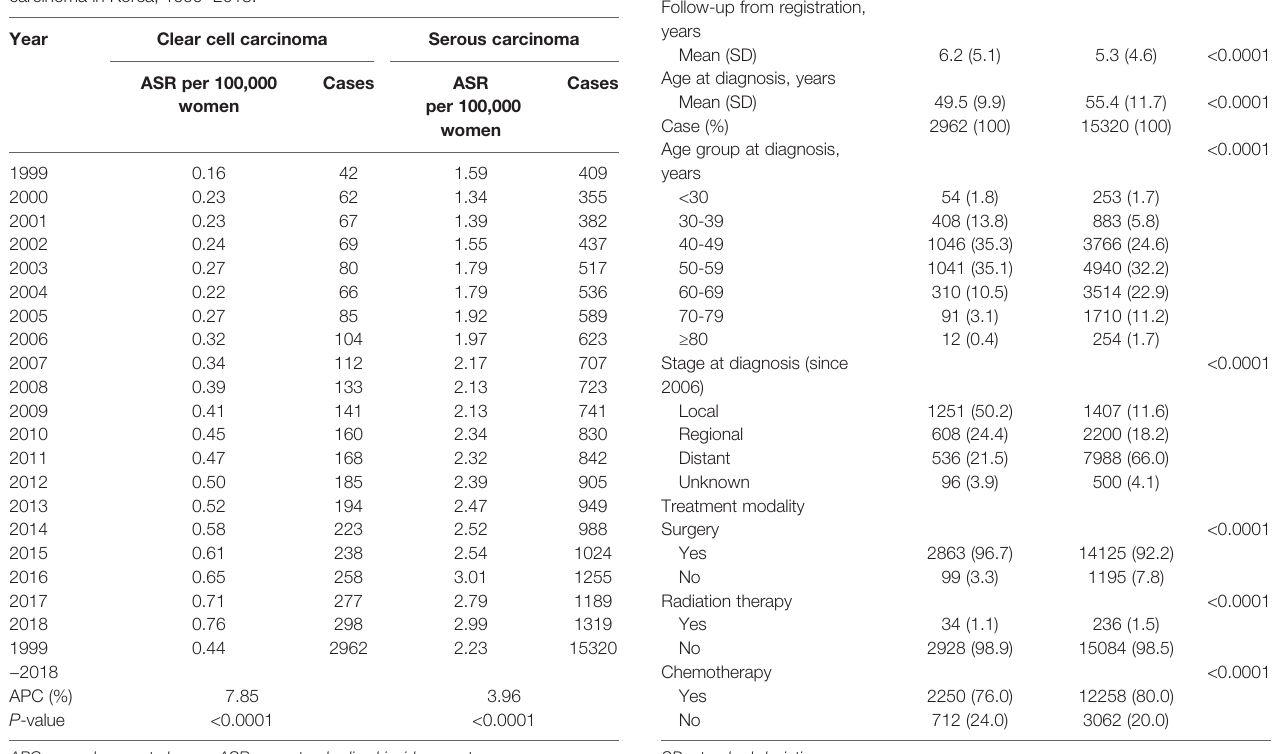
P Serous carci- noma noma